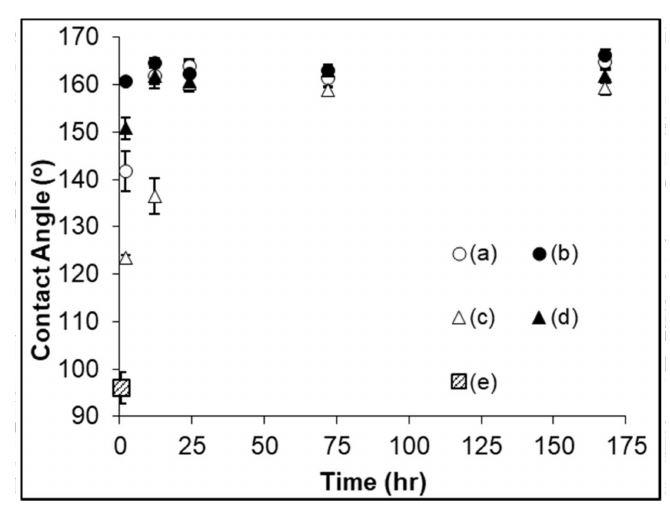
Figure 2. Surface wettability changes induced on pyrite by exposure to HH Medium and A. ferrooxidans over 168 h: The (a) advancing contact angle in HH medium; (b) receding contact angles in HH medium. (c) advancing contact angle when exposed to A. ferrooxidans ; (d) receding contact angles when exposed to A. ferrooxidans ; and (e) bare polished pyrite. Error bars represent sample the standard deviation in the contact angle measurements.